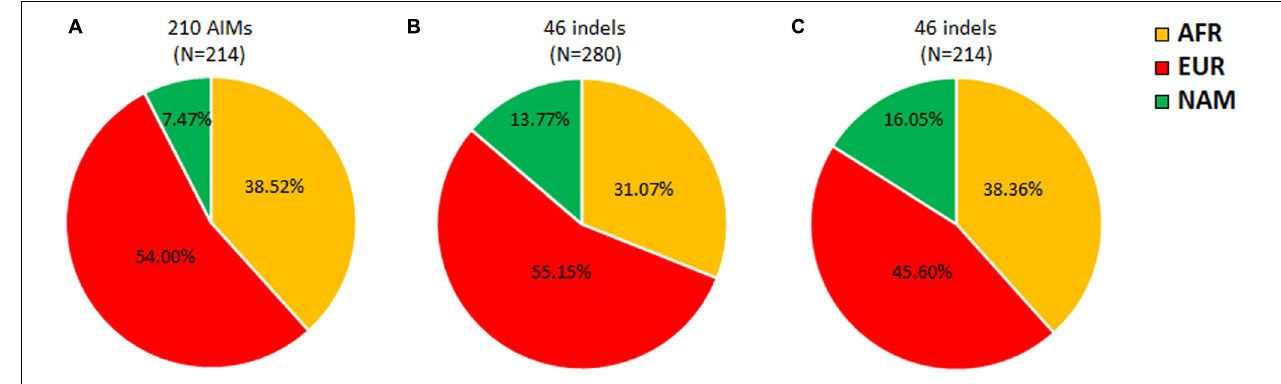
FIGURE 3 | Apportionment of ancestry in Rio de Janeiro based on 210 AIMs (A) , 46 indels from Manta et al., 2013 (B) , and the current dataset (C)